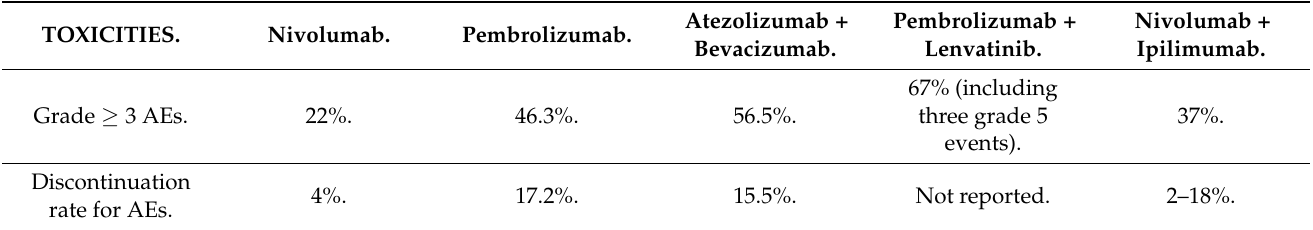
Table 5. Safety data from clinical trials of immune checkpoint inhibitors in advanced HCC [89]. TOXICITIES.